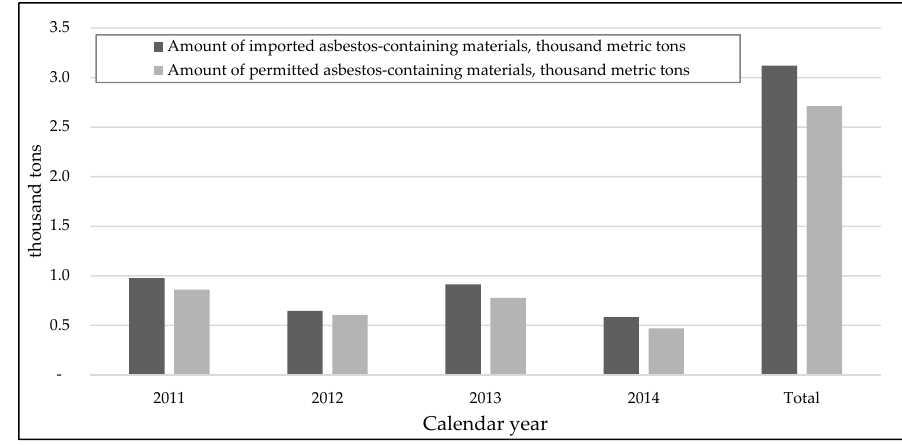
Figure 2. Comparisons of amount asbestos-containing materials permitted to be imported and actual importation.